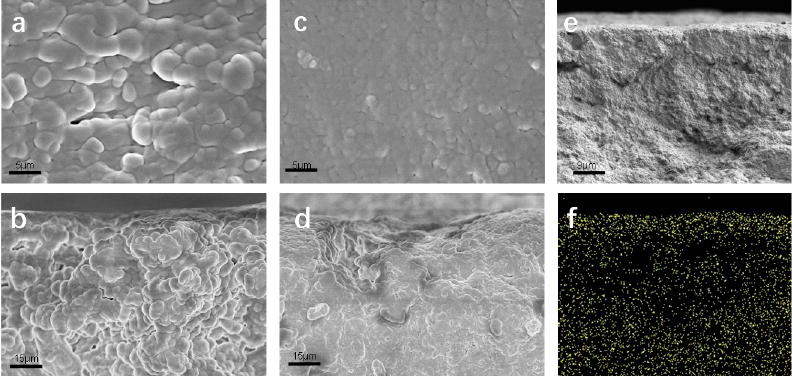
Figure 4. The ( a ) surface and ( b ) cross ‐ sectional SEM images of Daramic; the ( c ) surface and ( d , e ) cross ‐ sectional SEM images of the D ‐ DMAc membrane; ( f ) EDS mapping results of the D ‐ DMAc membrane.